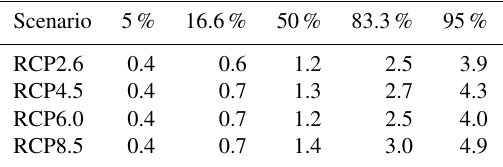
Figure 13. Projections from all models of the rate of future sea level contribution of the Antarctic ice sheet under different atmospheric carbon concentration scenarios following the procedure depicted in Fig. 1 and detailed in Sect. 2. The white line represents the median value, the dark shading the likely range (66th percentile around the median), and the light shading the very likely range (90th percentile around the median). Table 14. Sea level rate contributions from basal ice shelf melting from Antarctica in the middle of the 21st century (year 2050) from all models for the different emission scenarios in metres. Different from the sea level rise, the rate of sea level rise already depends on the scenario even in the first half of the century. Note that in RCP4.5, although it ends up lower in radiative forcing in the year 2100, it rises more quickly in the beginning of the century, which leads to a slightly higher contribution of Antarctica to the rate of sea level rise until 2050 compared to